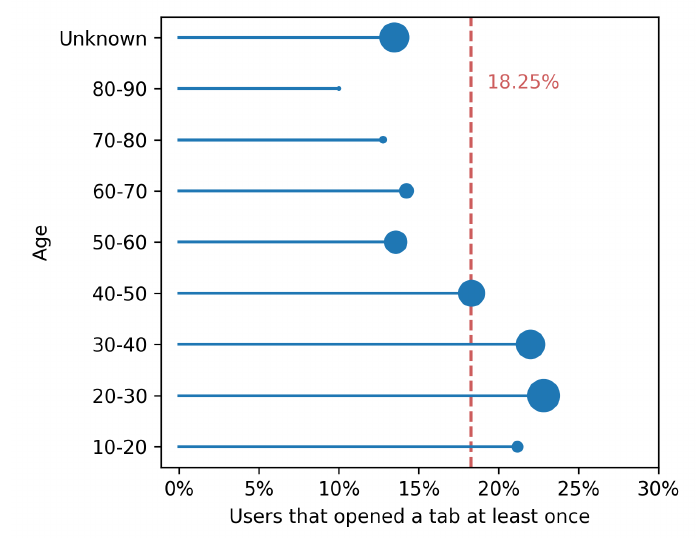
Figure 11. Percentage of users that opened a tab at least once, grouped by age. Lollipop size is proportional to the subgroup population in our dataset. On average, 18.25% of users opened another tab at least once. Teenagers and young adults in the age groups 10–20, 20–30, and 30–40 opened a tab more often than the